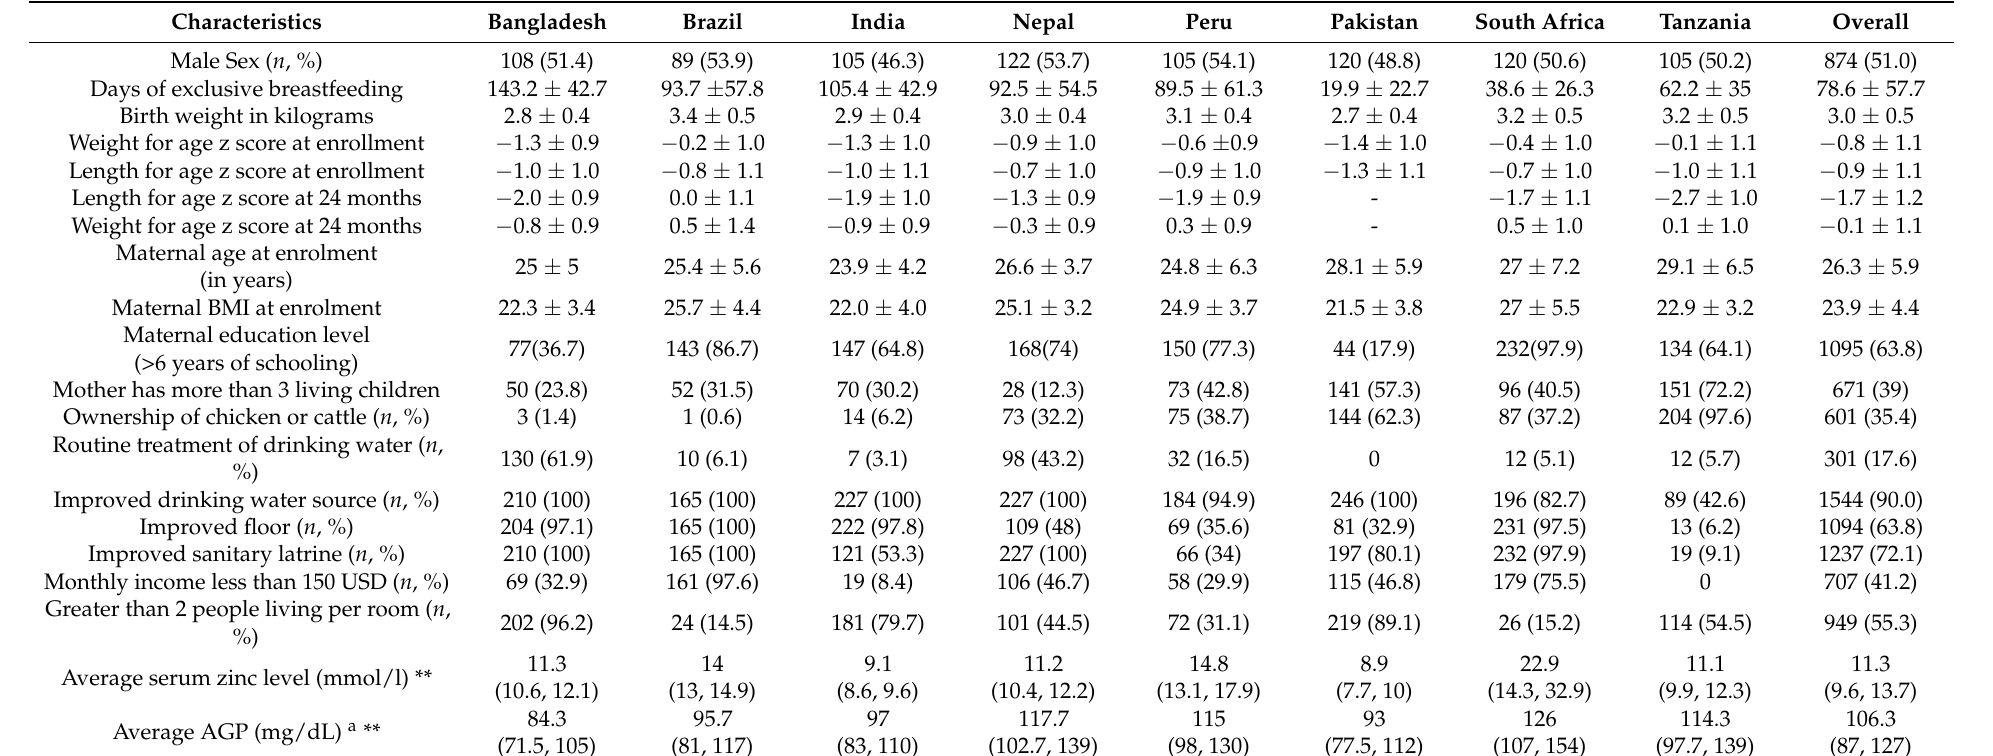
Table 1. General characteristics of the study participants enrolled at each of the eight study sites during the study